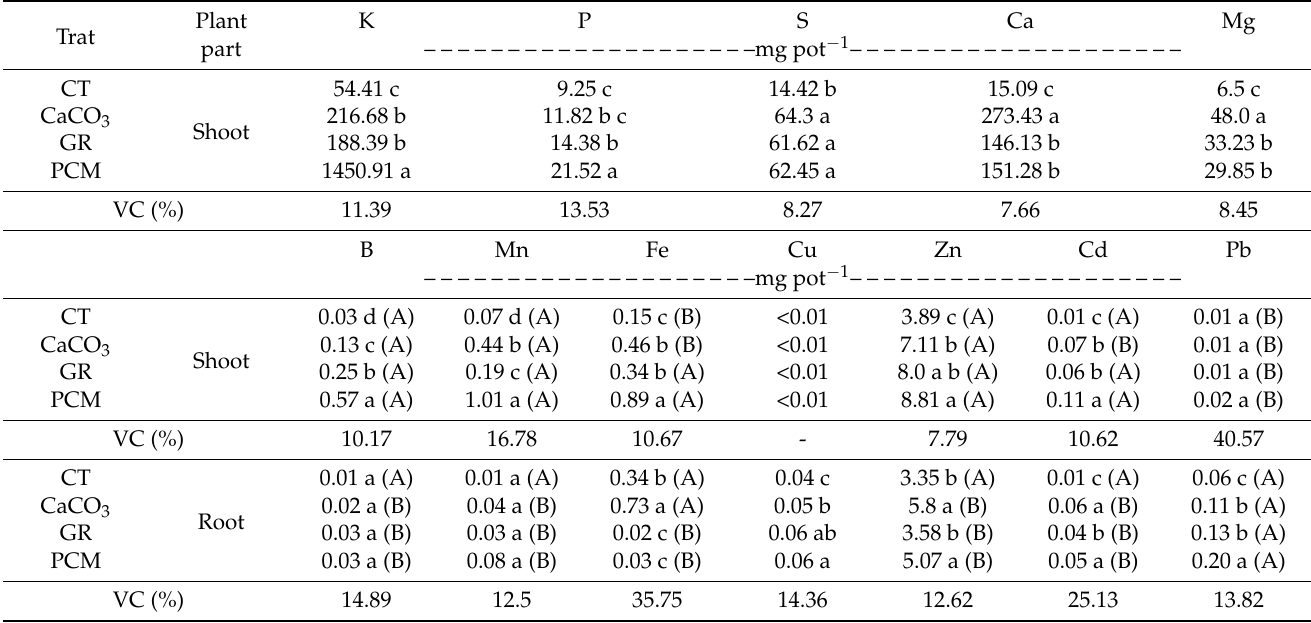
Table 5. Nutrient contents and potentially toxic elements accumulated in the shoots and roots of the plants as a function of the treatments